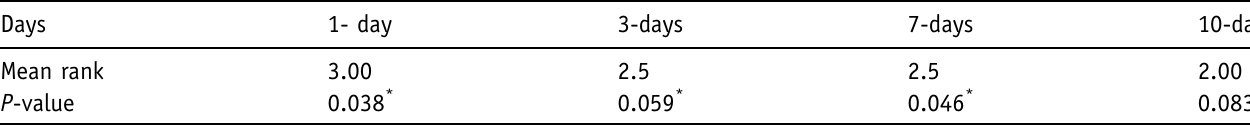
Table II. Wilcoxon Signed Ranks Test for immunohistochemical readings.